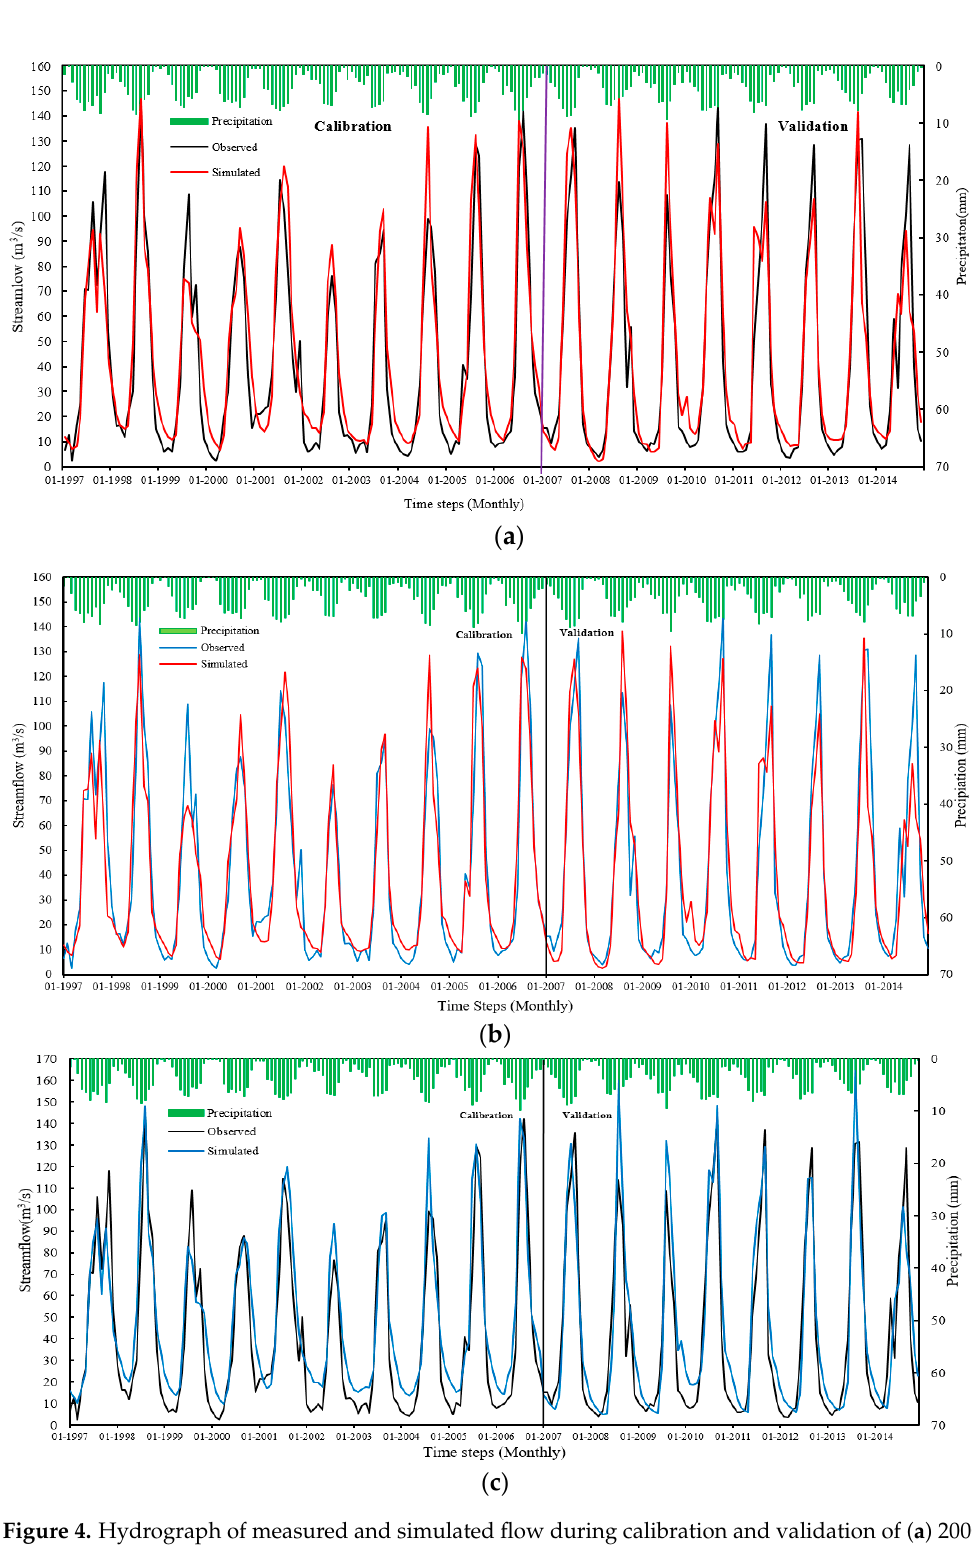
Figure 4. Hydrograph of measured and simulated flow during calibration and validation of ( a ) 2000, ( b ) 2010, and ( c ) 2020 reference periods. Table 2. Statistical performance indicators during calibration and validation LULC periods.